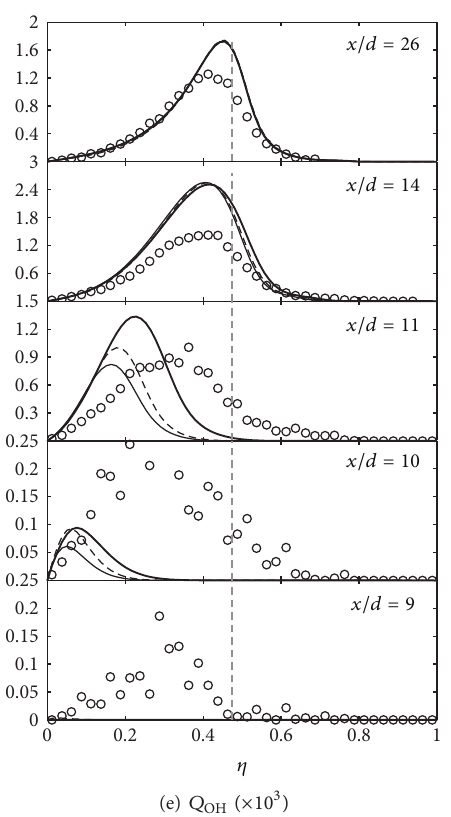
(× 10 2 ) , (d) 𝑄 (× 10 2 ) , and (e) 𝑄 (× 10 3 ) . , (c) 𝑄 O 2 H 2 H 2 O OH